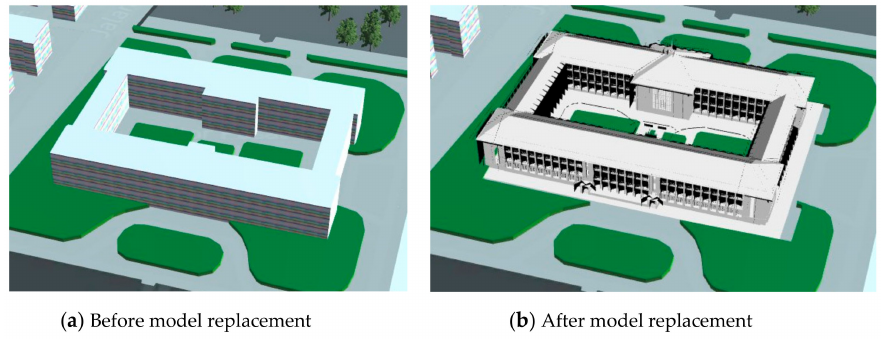
Figure 5. Replace model modifiers: before replacement ( a ) and after replacement ( b ).